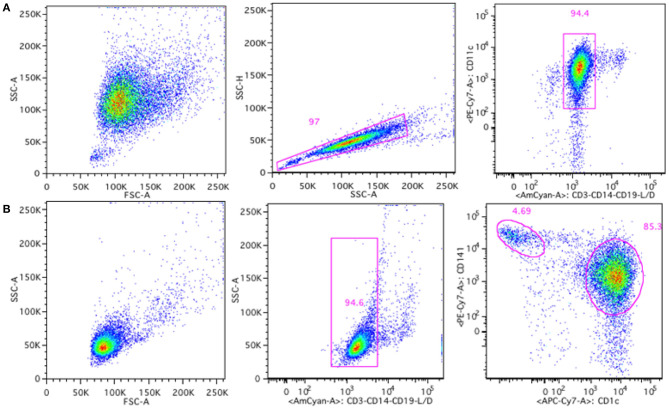
Gating strategy for moDCs and cDCs generated or isolated from human buffy coats. MoDCs were gated based on singlets and CD11c+, CD3−, CD14−, CD19− live cells (A) and cDCs were gated based on CD3−, CD14−, CD19− live cells, and subdivided in cDC1 type (CD141high) and cDC2 type (CD1c+) cells (B).